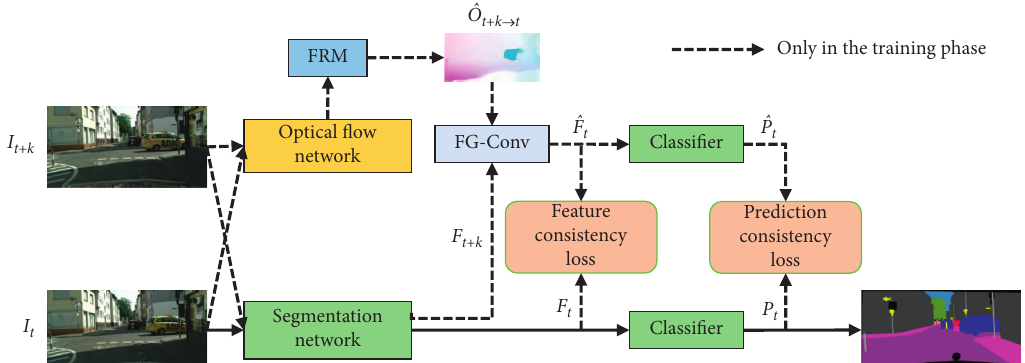
Figure 2: The overall structure of our DWNet framework. FRM denotes the flow refinement module. FG-Conv denotes the flow-guided convolution. Feature consistency loss and prediction consistency loss are both the temporal consistency loss, which improves the temporal consistency of video segmentation. The dotted lines denote that the components are only used in the training phase and will be removed in the inference